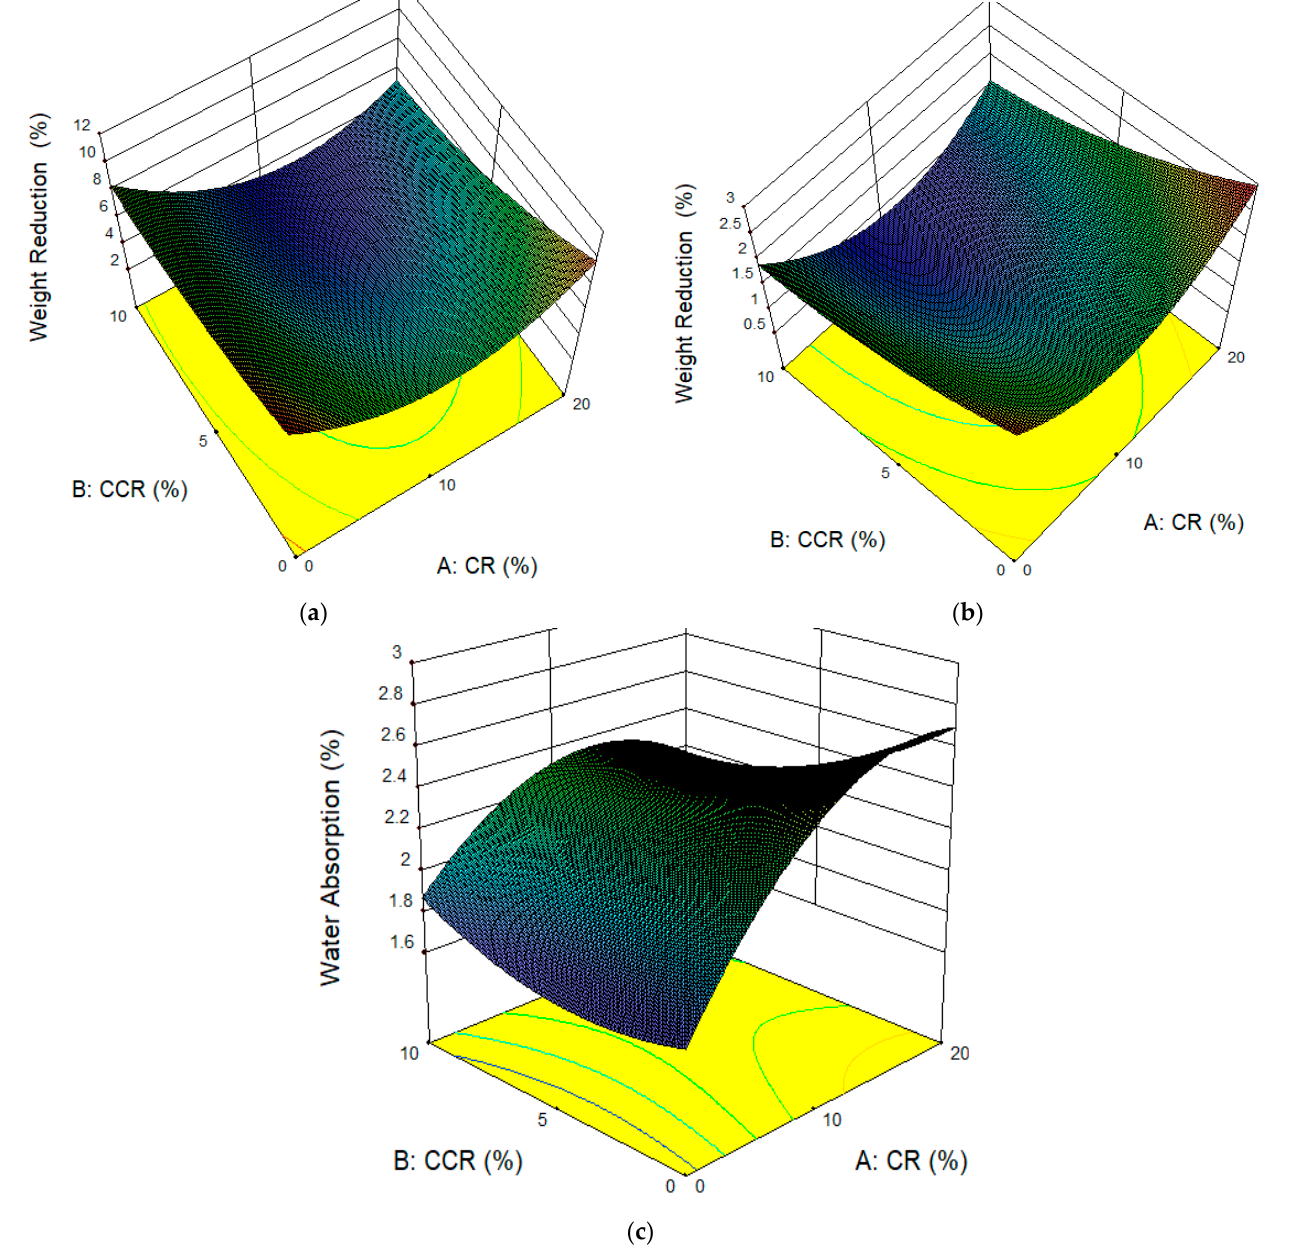
Figure 4. 3D Response surface plot for durability properties for ( a ) Weight Loss (H 2 SO 4 ), ( b ) Weight Loss (MgSO 4 ), and ( c ) Water Absorption.